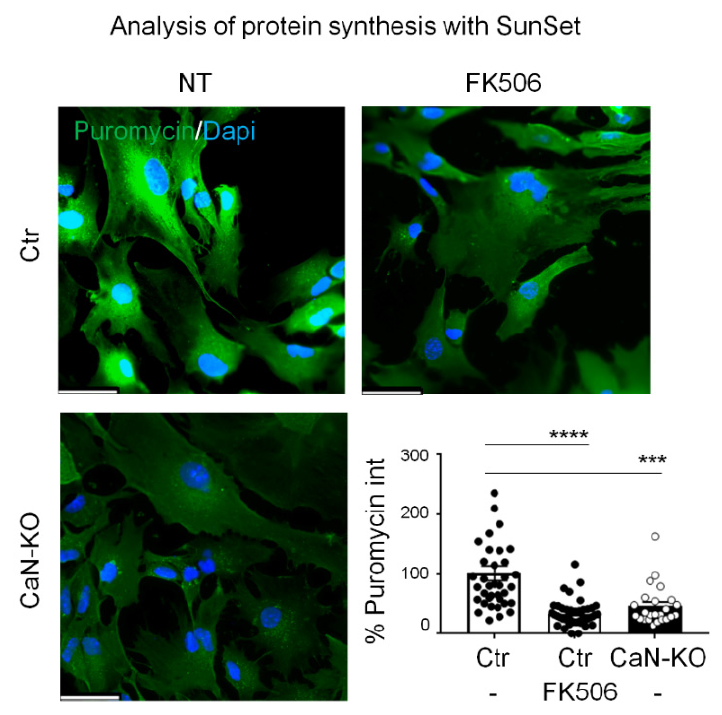
Figure 6. Protein synthesis analysis in Ctr, FK506-treated Ctr and CaN-KO astrocytes. Ctr, FK506- treated Ctr and CaN-KO astrocytes were pulsed with 4 µM puromycin, fixed and analysed by IF with anti-puromycin antibody (green) and reacted with DAPI to stain the nuclei (blue). Images were acquired with a Leica Thunder imager 3D live cell microscope, scale bar 41.6 µm. Data are expressed as means ± SEM of n cells Ctr = 37, FK506-treated Ctr = 44, CaN-KO = 24, from three independent experiments. one-way Anova, Dunnett’s multiple comparison analysis, *** p < 0.001 and **** p < 0.0001.